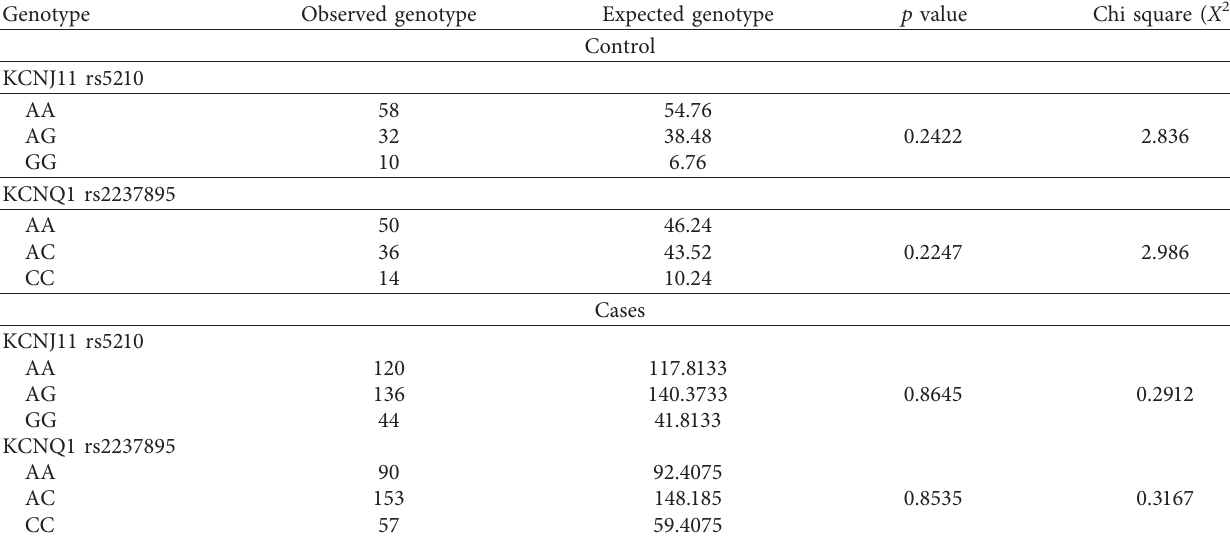
Table 4: Observed and expected genotypes of KCNJ11 and KCNQ1 polymorphism in control and cases.